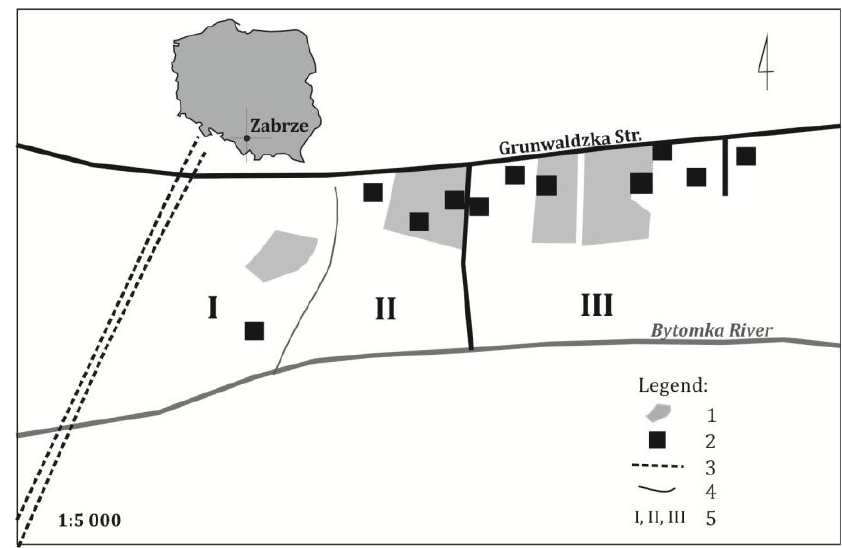
Fig. 1. Location of the study area near the city of Zabrze 1 – area of trees and shrubs; 2 – buildings; 3 – railroad; 4 – drainage ditch; 5 – study